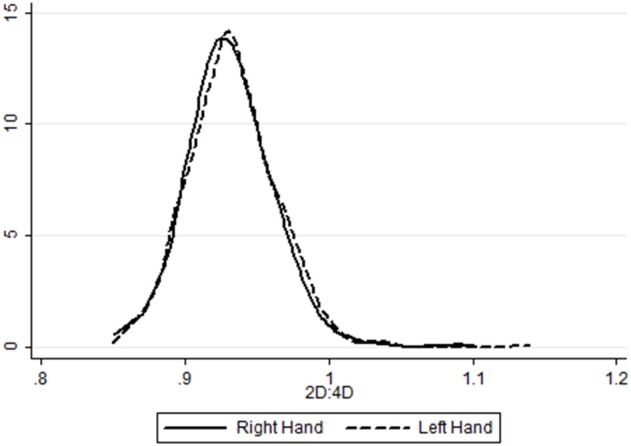
Kernel densities of 2D:4D measures.